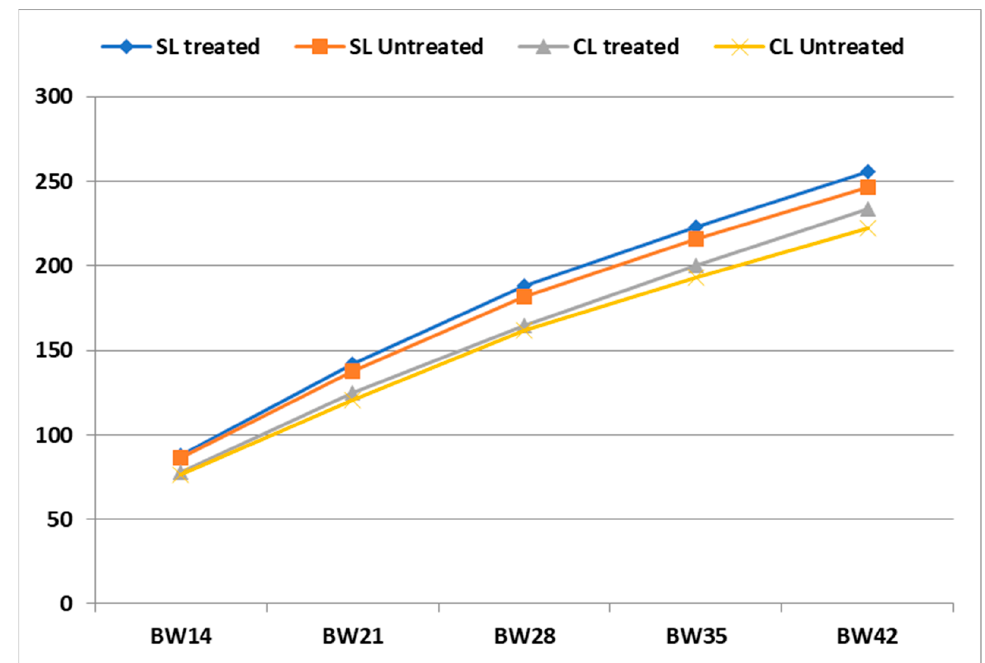
Figure 2. Treatment effects on body weight (BW, g) for each line separately.